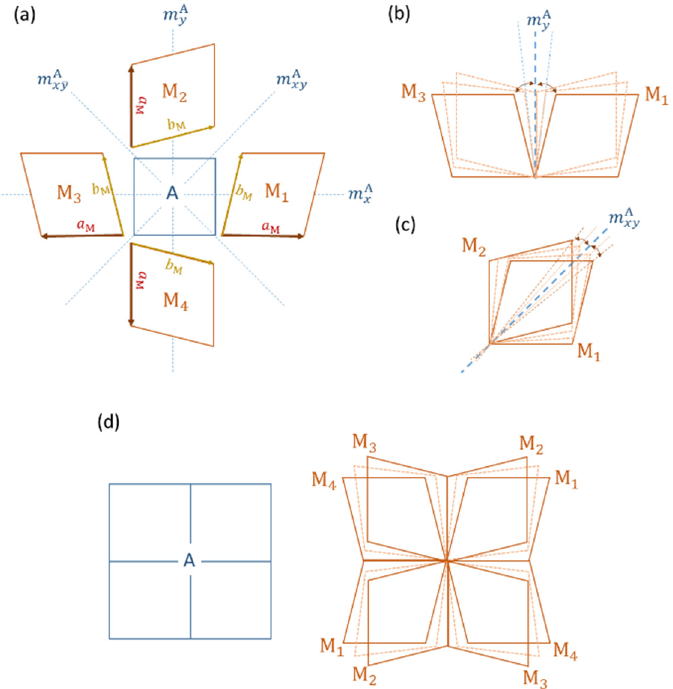
Figure 1. A 2D example of a square austenite (A) → parallelogram martensite (M) transformation. ( a ) There are four orientation variants, assuming 𝐚 M //𝐚 A for the “natural” OR. ( b ) Closing-gap OR // (1,0) (1,0) //(1,0) and associated rotation gradients between the variants M 1 and M 3 . This M1 M3 A new OR maintains invariant the vertical reflection plane 𝑚 𝑦𝐴 . ( c ) Closing-gap OR (1 (cid:3364) , 1) (cid:1) (cid:0) (cid:1) (cid:0) (cid:1) / (1 (cid:3364) , 1) and associated rotation gradients between the variants M 1 and M 2 . This new OR main- 1,1 // 1,1 // 1,1 and associated rotation gradients between the variants M 1 and M 2 A M1 M2 A tains invariant the diagonal reflection plane 𝑚 𝑥𝑦𝐴 . ( d ) Global compatibility between the variants me- diated by the closing-gap ORs and associated orientation gradients.